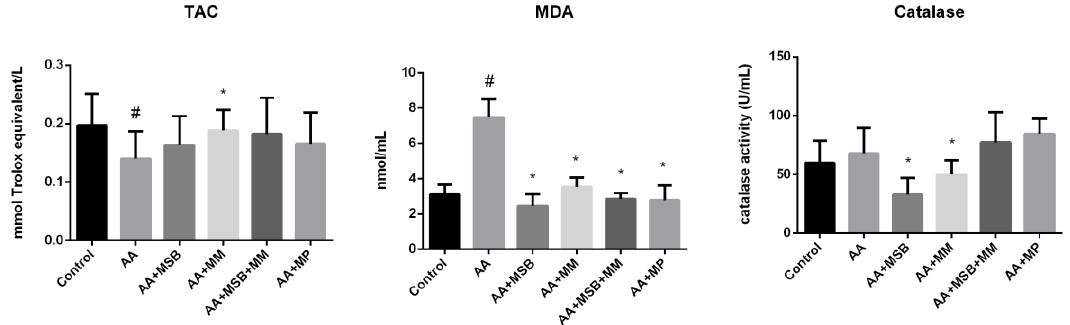
Figure 4. TAC, MDA, and catalase levels. * p < 0.05 compared to AA; # p < 0.05 compared to control. Abbreviations: TAC, total antioxidant capacity; MDA, malondialdehyde; AA, 4% acetic acid; MSB, MegaSporeBiotic™; MM, MegaMucosa™; MP, methylprednisolone. The bars represent mean values with standard deviations.